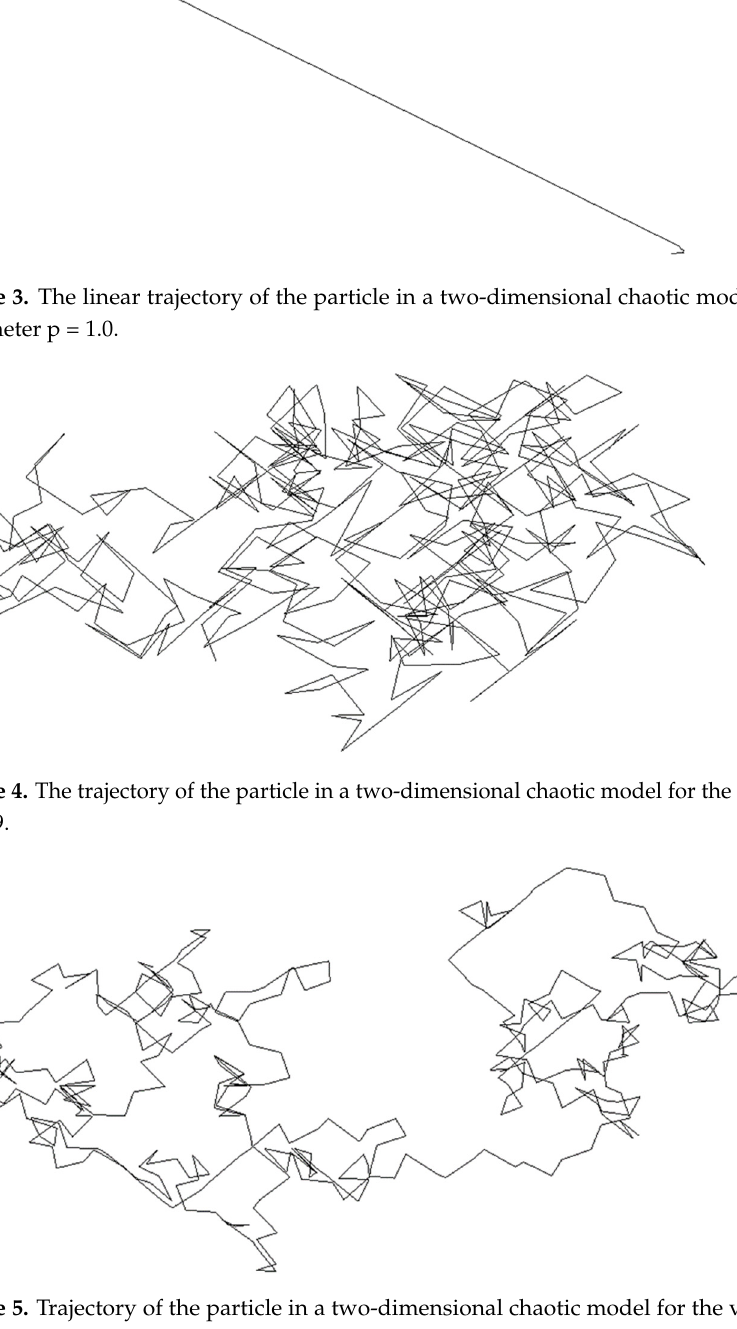
Figure 6. Trajectory of the particle in a two-dimensional chaotic model for the value of parameter, p = 0.7.